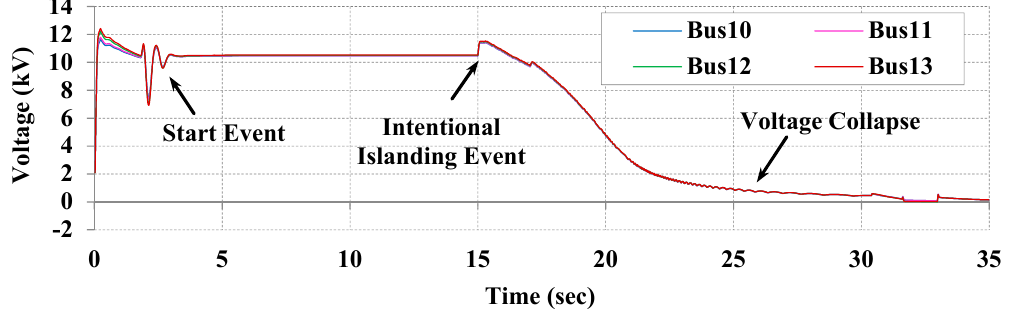
Figure 10. Voltage collapse in the island-2 after intentional islanding event.